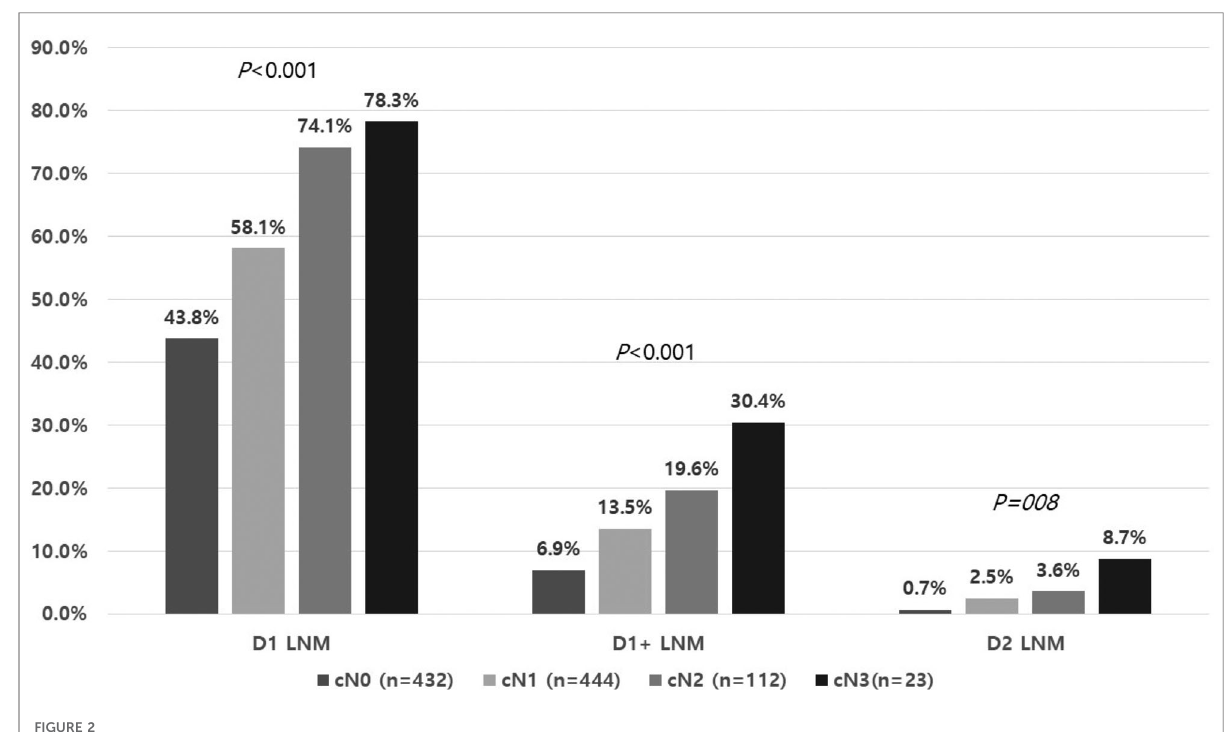
Values are expressed with number and percentage.